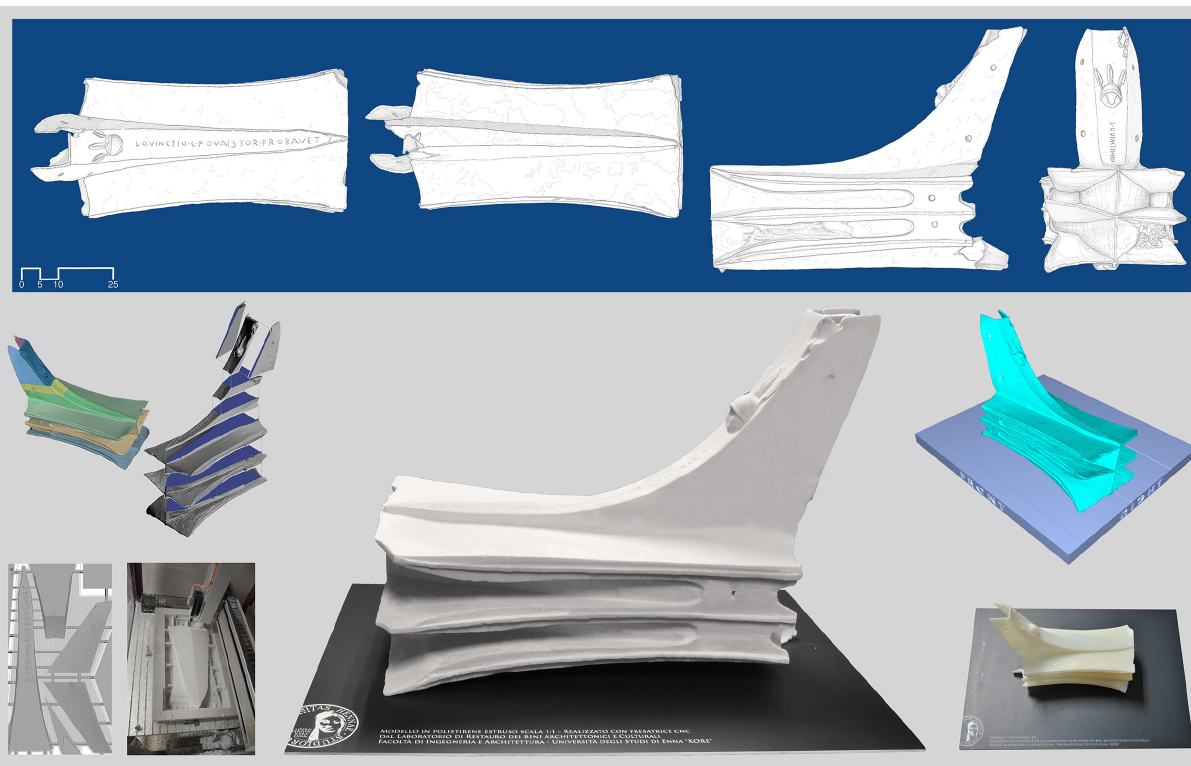
Figure 7. Maquette of the rostrum realised in scale 1: 1 by CNC